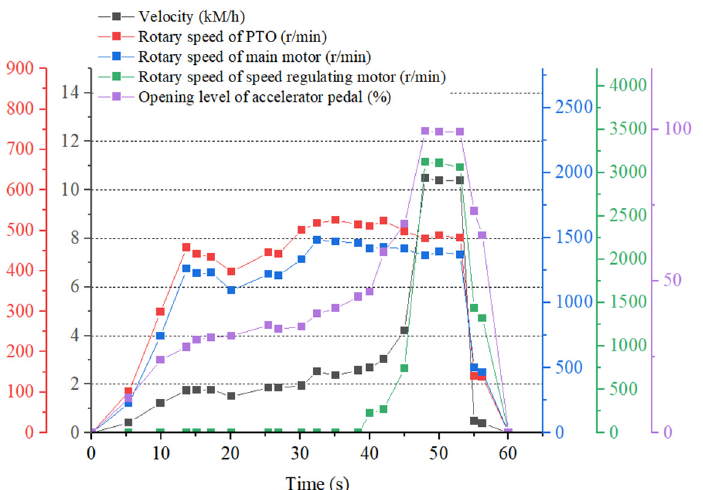
Figure 20. Curves of speed, PTO speed, main motor speed, speed control motor speed, and accelerator pedal opening.